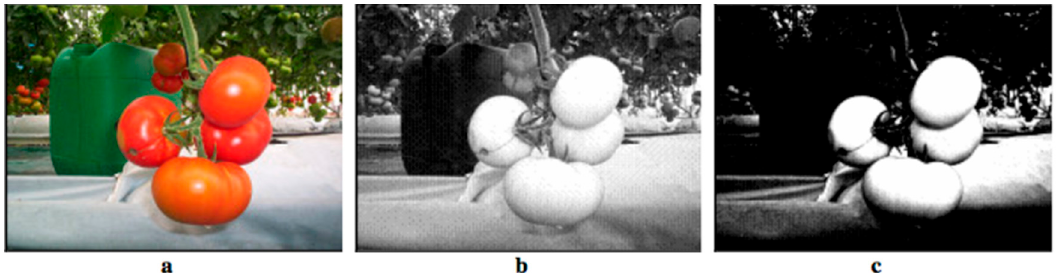
Figure 6. ( a ) Original image; ( b ) R plane; and ( c ) power transform and contrast enhancement.